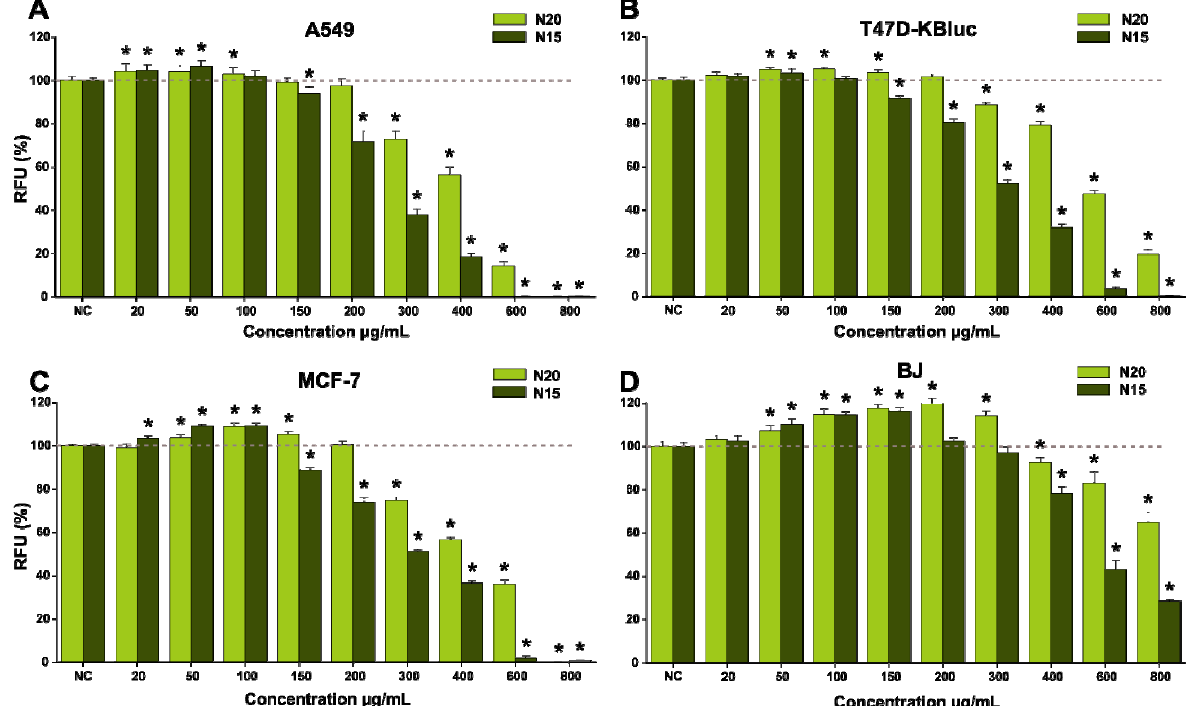
Figure 8. Effects of the Juglans sp. extracts (N20, N15) on the cancerous cell lines A549 ( A ), T47D-KBluc ( B ) and MCF-7 ( C ) and on normal human foreskin fibroblasts (BJ) cells’ ( D ) viability after 24 h exposure. The results are presented as relative mean values ± standard deviations, where the negative control (NC) is 100%. Significant differences in comparison with NC (ANOVA + Dunnett’s; p < 0.05) are marked with *.